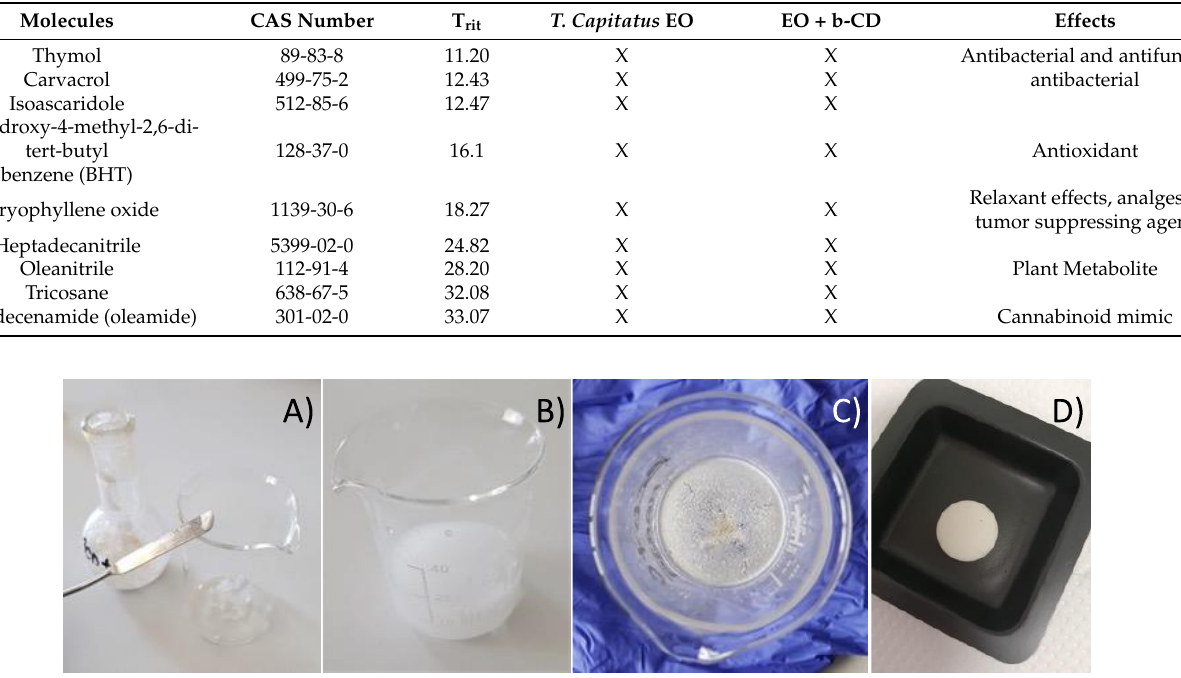
Figure 6. Tablet preparation steps. ( A – C ) b-CD – EOs powder mixtures embedded in polyvinylpyrrolidone (PVP). ( D ) The obtained solid-state composite powder was pressed in order to obtain 1 cm diameter round tablets.